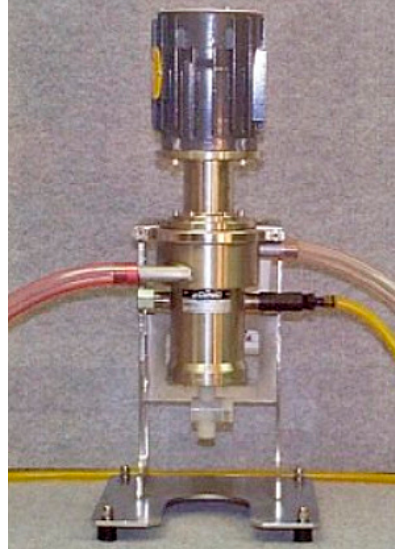
Figure 3. Laboratory scale extraction centrifuge (courtesy of CINC Inc.).